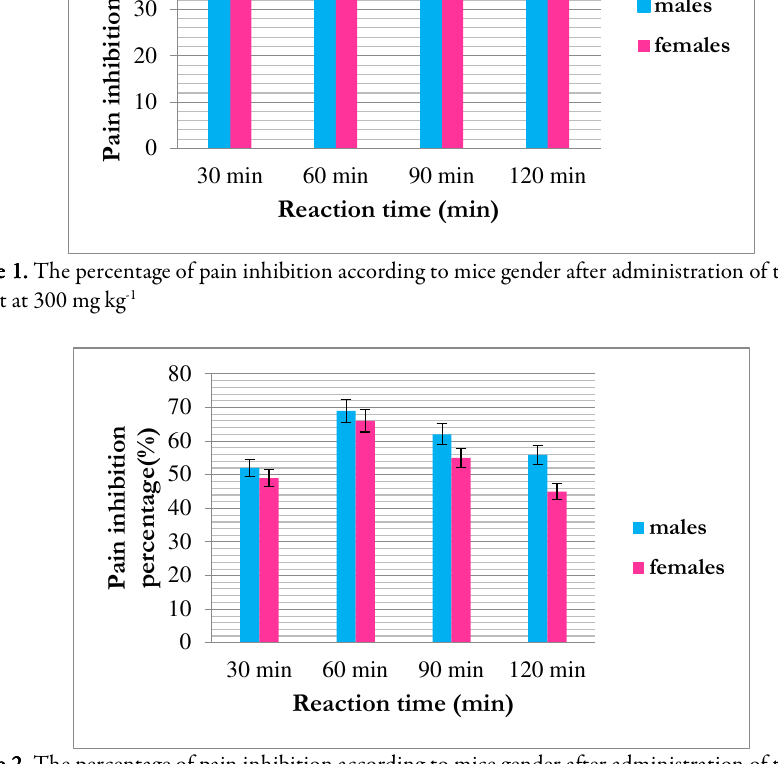
Figure 2. The percentage of pain inhibition according to mice gender after administration of the aqueous extract at 500 mg kg -1